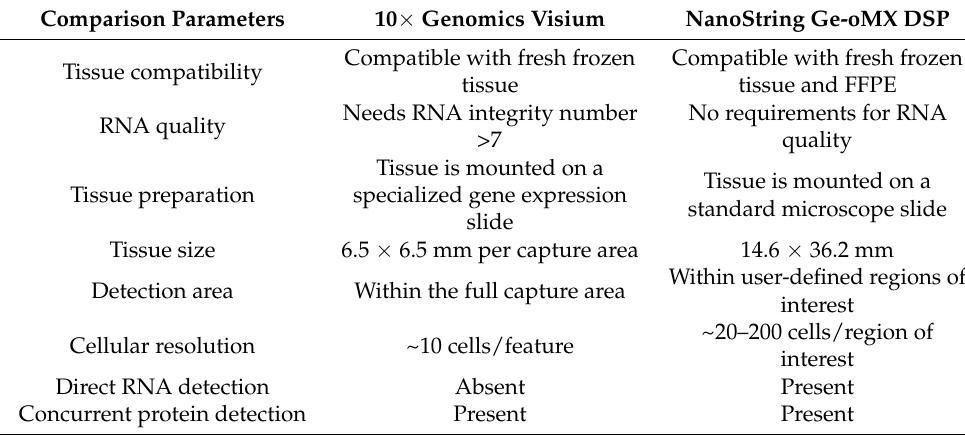
Table 1. Comparison between commonly used commercially available spatial transcriptional profiling platforms (Adapted from Bassiouni et al. [60]). Comparison Parameters 10 × Genomics Visium NanoString Ge-oMX DSP Compatible with fresh frozen Compatible with fresh frozen Tissue compatibility tissue tissue and FFPE Needs RNA integrity number No requirements for RNA RNA quality quality Tissue is mounted on a Tissue is mounted on a specialized gene expression standard microscope slide